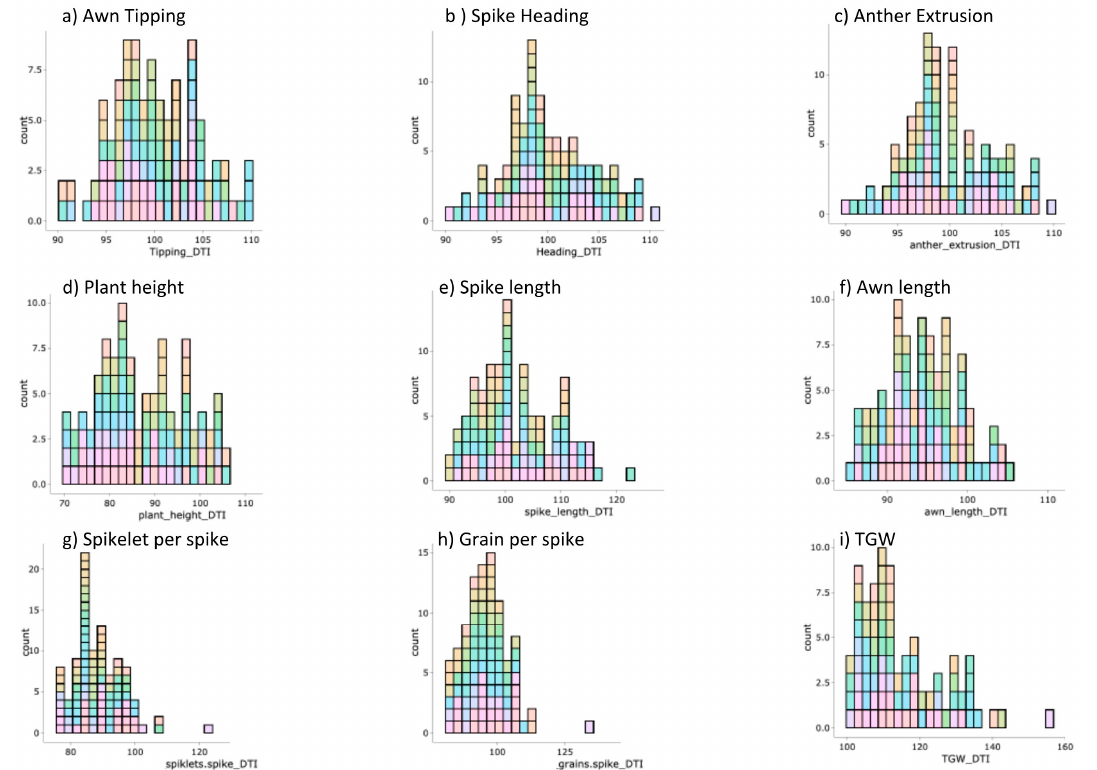
Figure 2. Histogram of phenotypic values distribution analysis of drought tolerance index variation of the studied traits in 121 spring barley accessions under control and drought stress. ( a ) Awn Tipping, ( b ) Spike Heading, ( c ) Anther Extrusion, ( d ) Plant Height, ( e ) Spike length, ( f ) Awn Length, ( g ) Spikelet per Spike, ( h ) Grain per Spike and ( i ) Thousand Grain Weight Table 2. Analysis of variance and heritability for the measured traits under control and drought treatments.